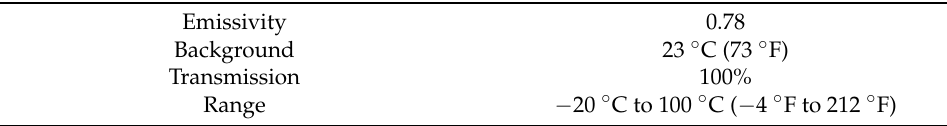
Table 3. Settings of the IR camera used for the